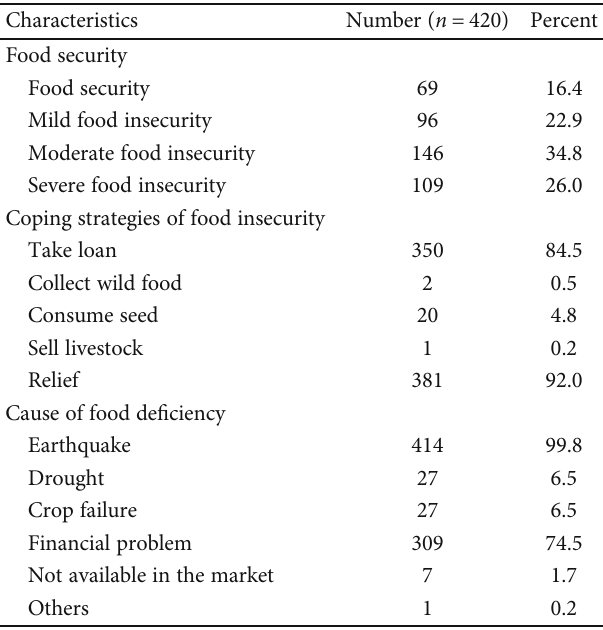
Table 3: Household food insecurity-related characteristics of study